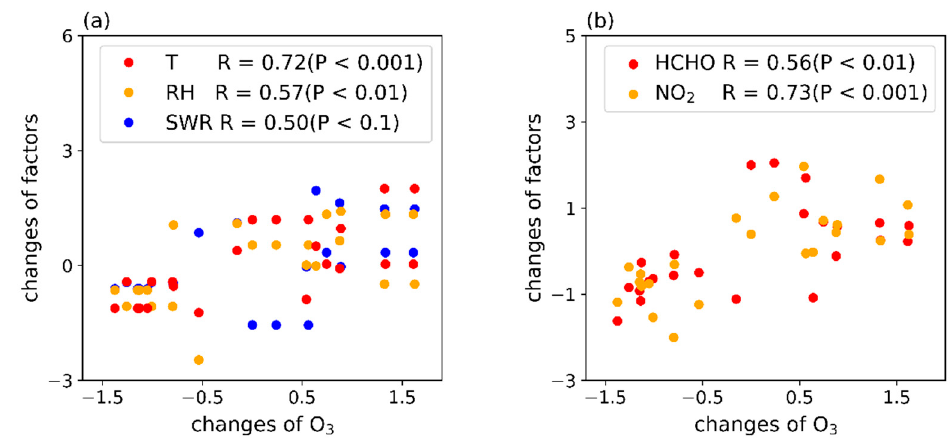
Figure 5. Scatter plots of standardized values of percentage changes between pre-lockdown and lockdown periods of O 3 and ( a ) temperature (T), relative humidity (RH) and mean surface net shortwave radiation flux (SWR), and ( b ) HCHO and NO 2 from monitoring stations in PRD in 2020.